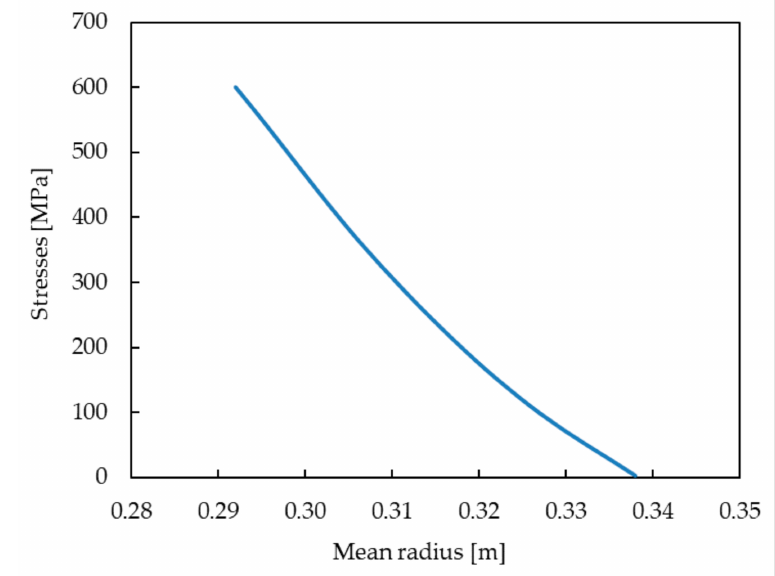
Figure 11. Change of stress values in the turbine